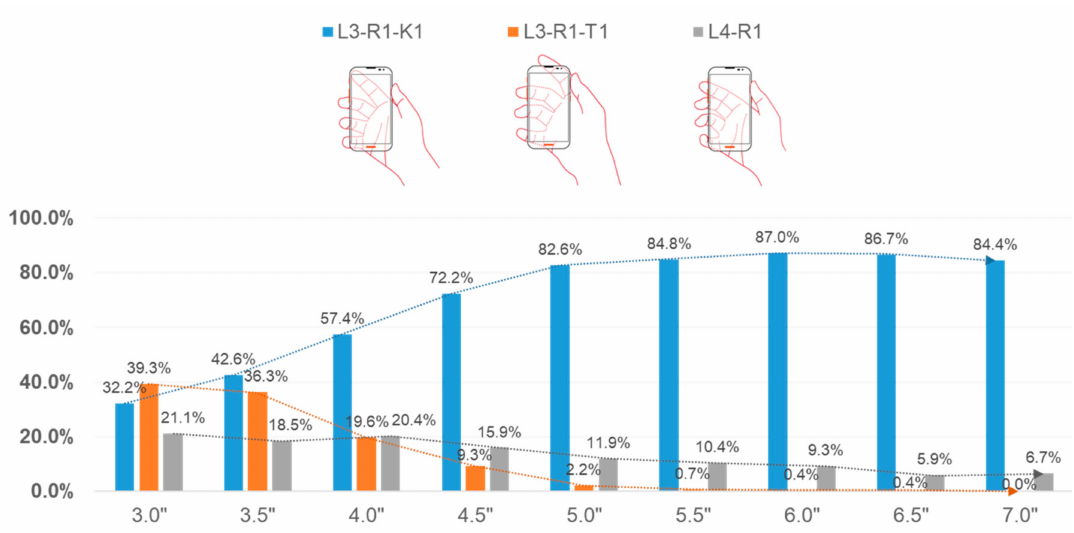
Figure 5. The frequency distribution of grip posture by smartphone size for hard key operations on a smartphone.